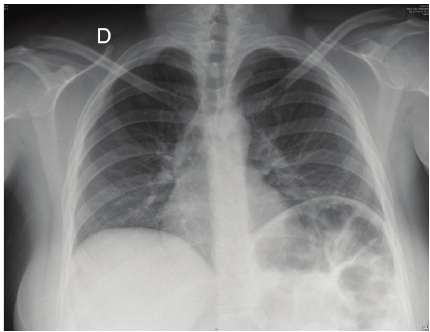
Figure 1: Chest X-ray showing left hemidiaphragmatic elevation due to the accumulation of gas in the splenic angle of the colon.